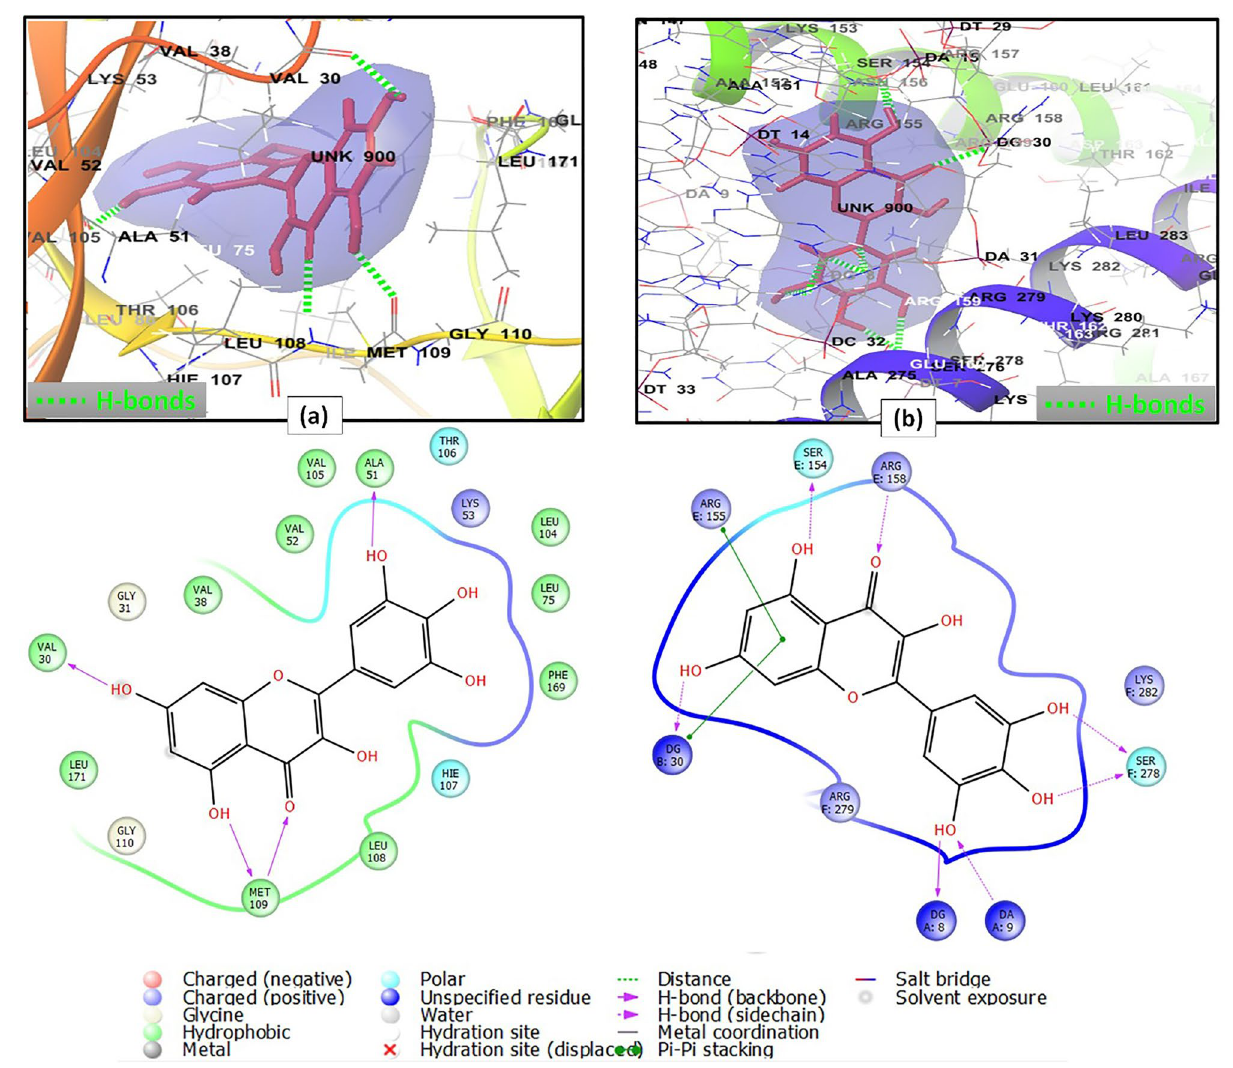
Figure 7. 2D and 3D interaction diagrams of ( a ) myricetin in the active site of mitogen-activated protein kinase 14 (PDB ID 6HWU) ( b ) myricetin in the active site of proto-oncogene c-Fos (PDB ID